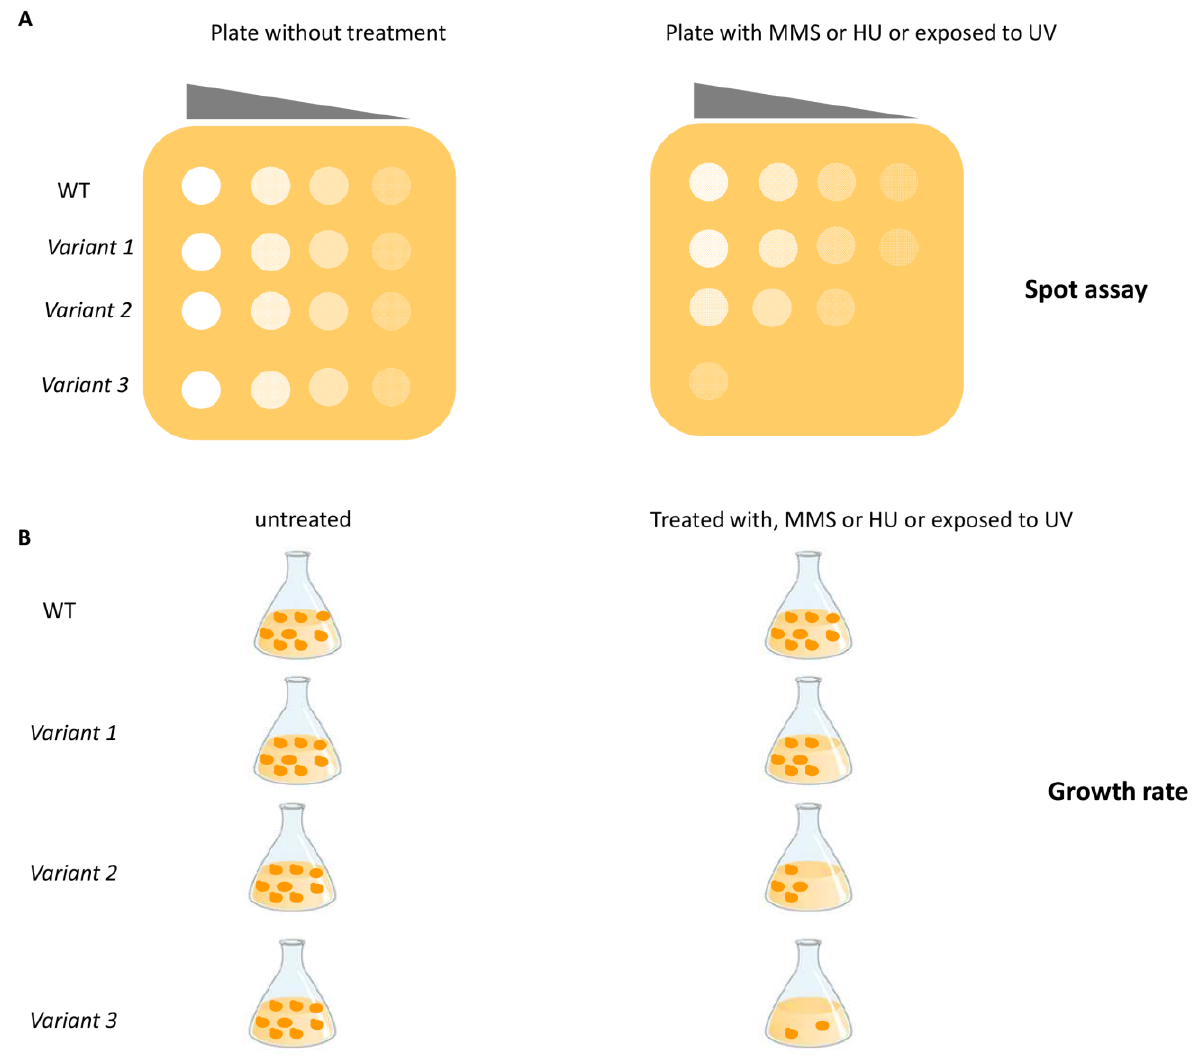
FIGURE 2: Schematic representation of functional assays based on DNA damage sensitivity . (A) Sensitivity to chemical or physical agents is determined by the spot assay. An overnight culture of yeast cells is serially diluted (10-fold dilution) and spotted onto plates containing the specific DNA damaging agent or are treated with UV. The effect of variants is determined by comparing growth of yeast expressing the vari- ants vs WT. (B) The sensitivity to DNA damaging agents is evaluated by OD 600 measurement of cell growth in liquid medium. Yeast cells are grown in medium containing the chemical agents or exposed to UV irradiation. The sensitivity of yeast cells carrying the gene variants is compared to yeast cells carrying the WT gene. MMS: methyl methane sulfonate; HU: